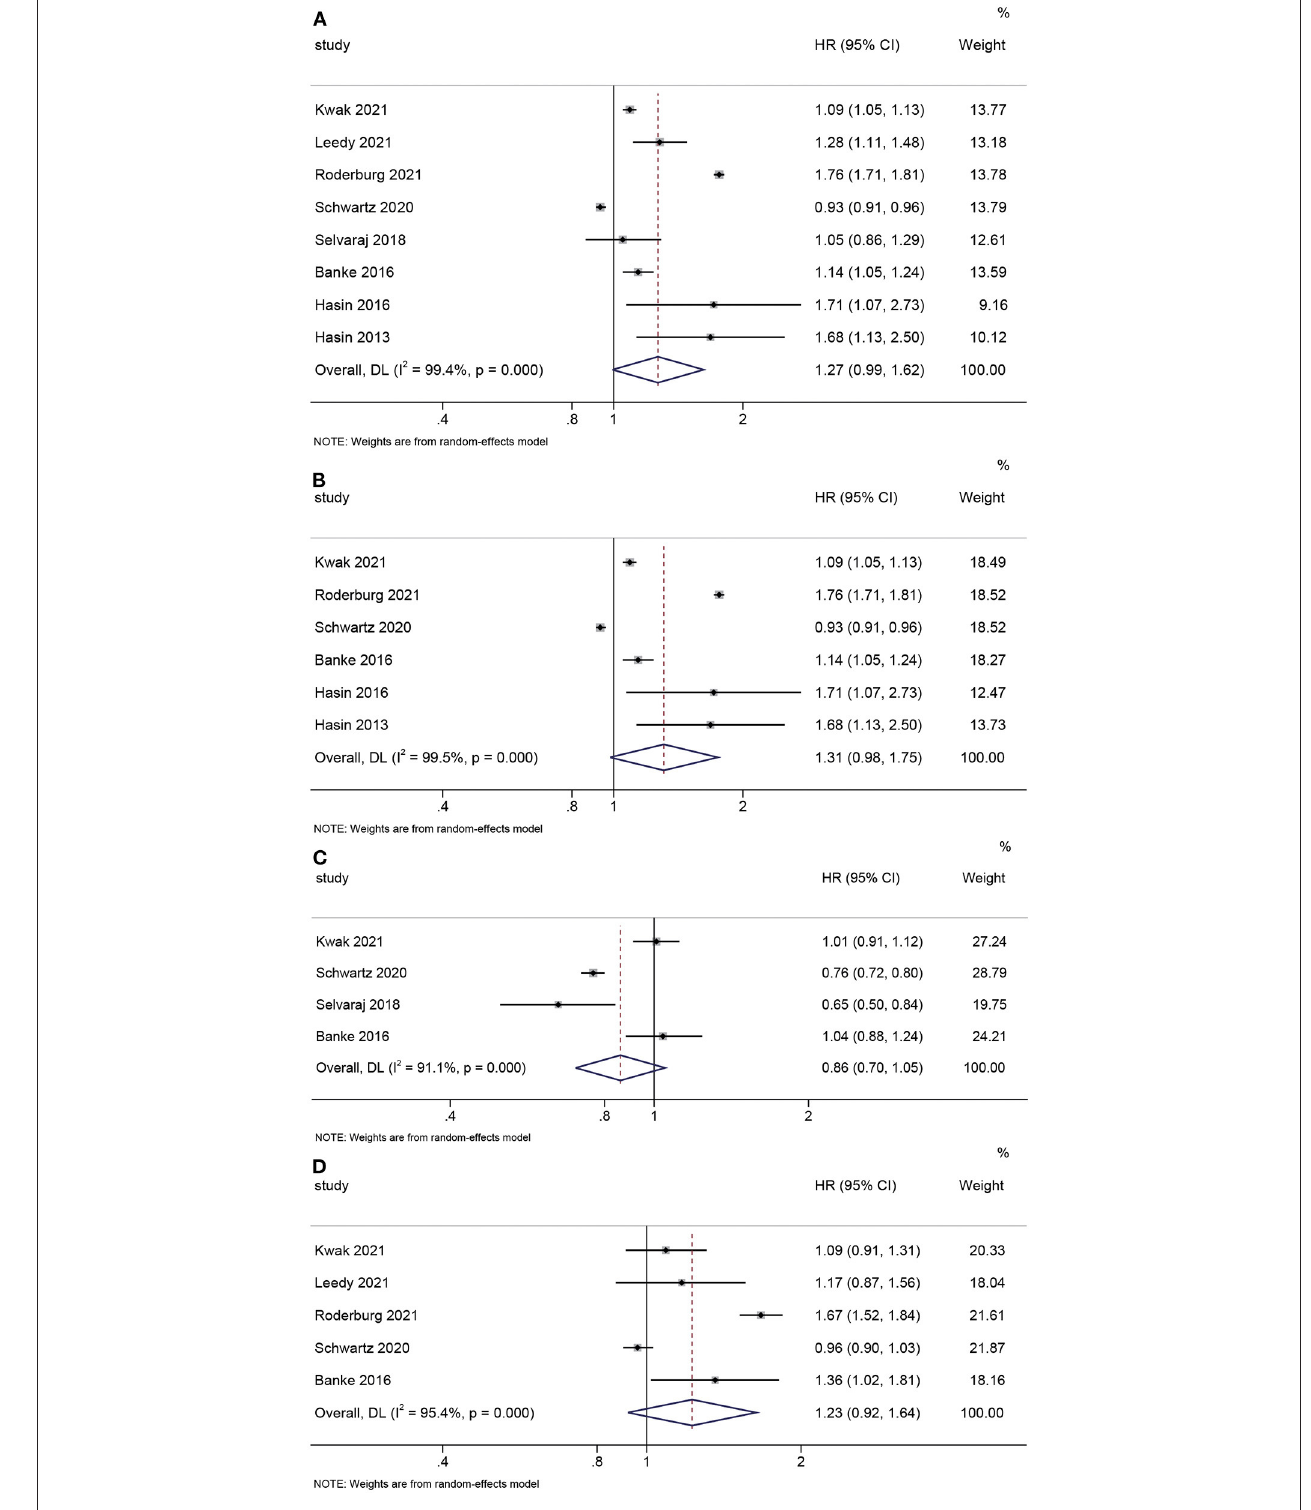
FIGURE 1 | Forest plots. (A) Pooled hazard ratio for all types of cancer: HF vs. control. (B) Sensitivity analysis. (C) Pooled hazard ratio for prostate cancer: HF vs. control. (D) Pooled hazard ratio for breast cancer: HF vs. control.